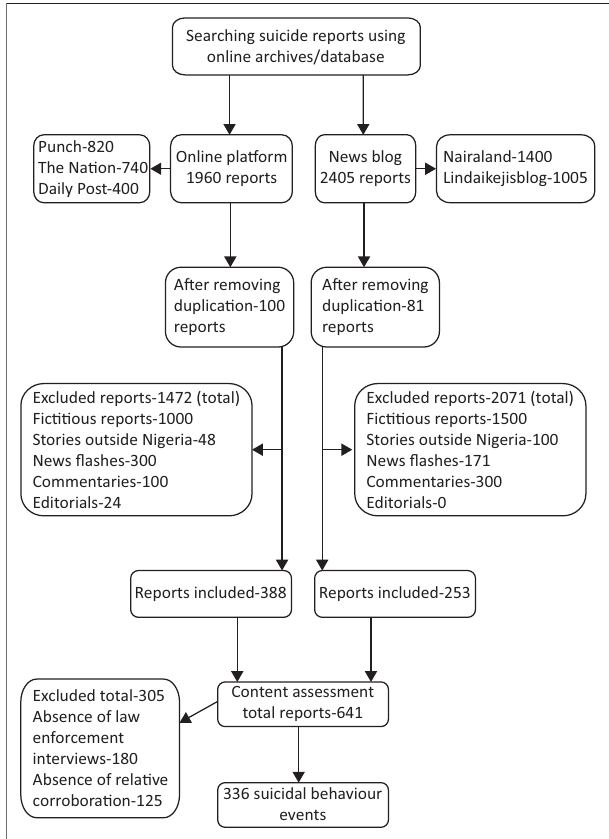
FIGURE 1: Selection process of media-reported suicide events from 2016 to